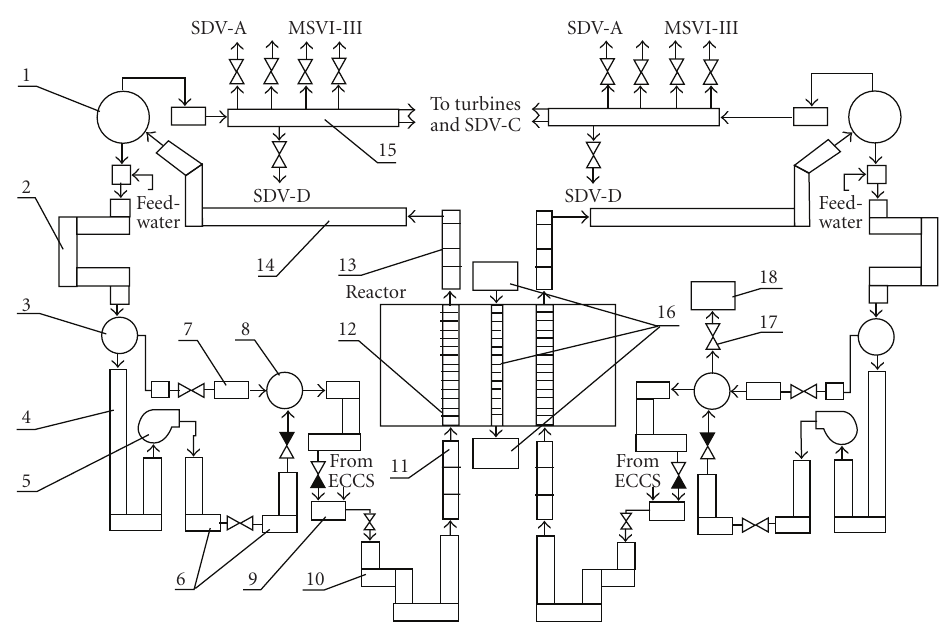
Figure 19: Representative RCS nodalization for